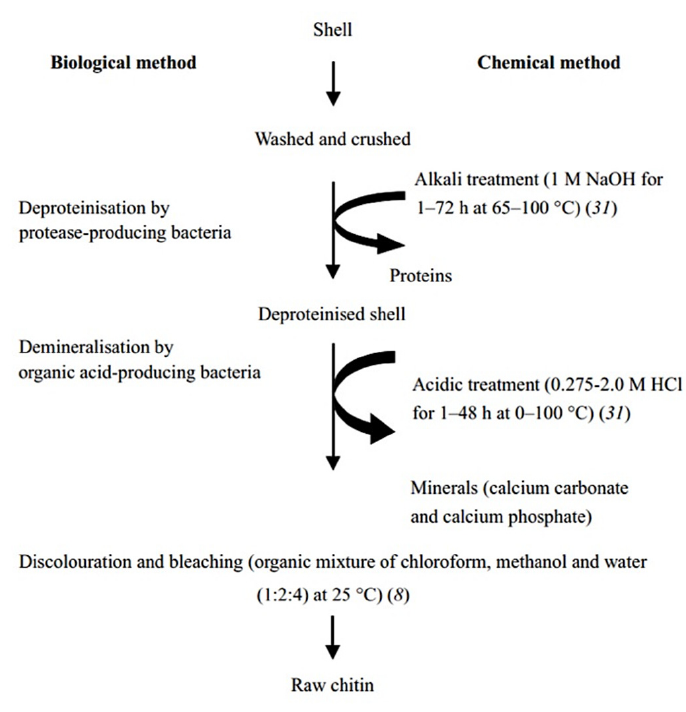
Figure 11. Chitin recovery by chemical and biological methods [56].